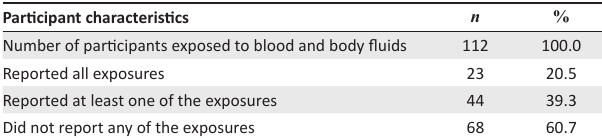
TABLE 4: Reporting patterns.